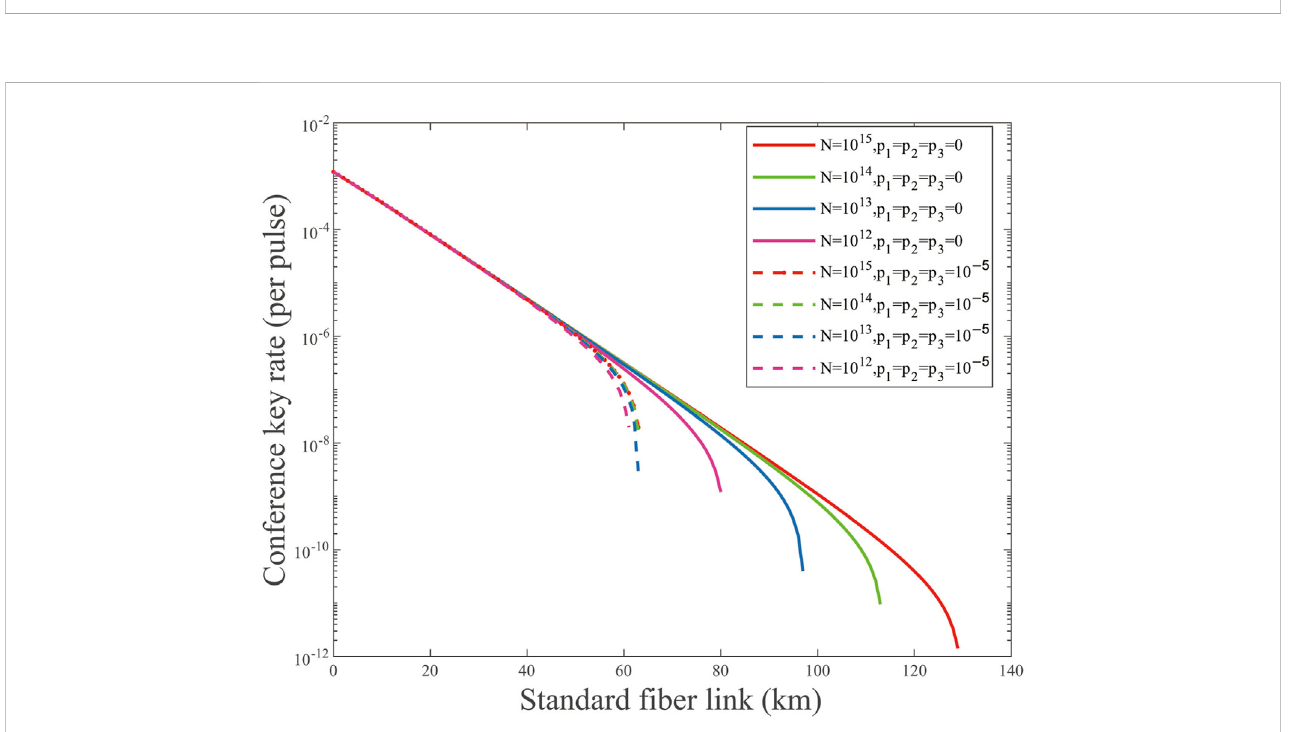
FIGURE 3 (Color online) Conference key rate (per pulse) on a logarithmic scale vs. transmission distance for p 1,2,3 = 0, 10 − 5 and different total numbers of transmitted signals N = 10 x ( x = 15, 14, 13, 12). The solid lines are the results of p 1,2,3 = 0, and the dashed lines are the results of p 1,2,3 = 10 − 5